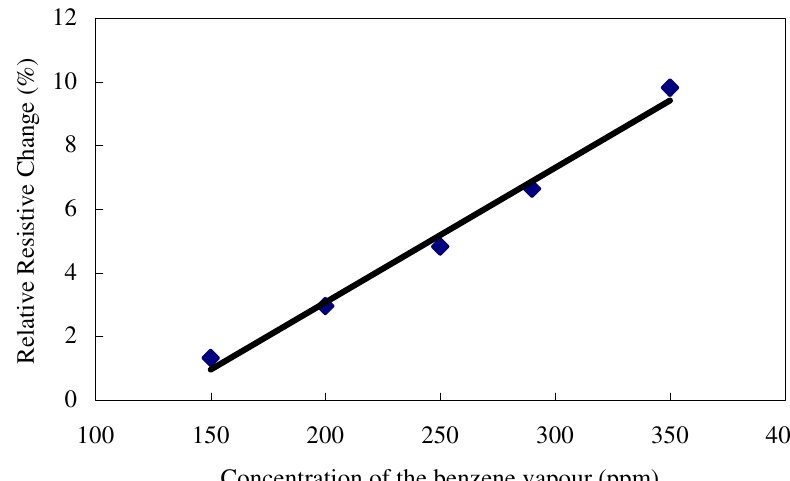
Figure 4. Variation in relative resistance ∆ R of a fresh TiO concentration of benzene in the carrier